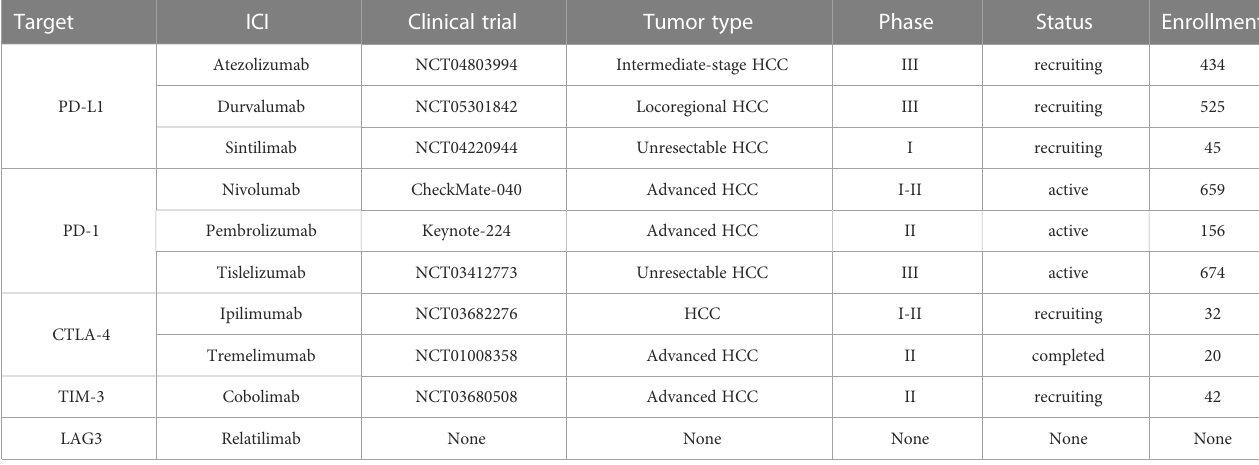
TABLE 1 Immune checkpoint inhibitors and their targets in